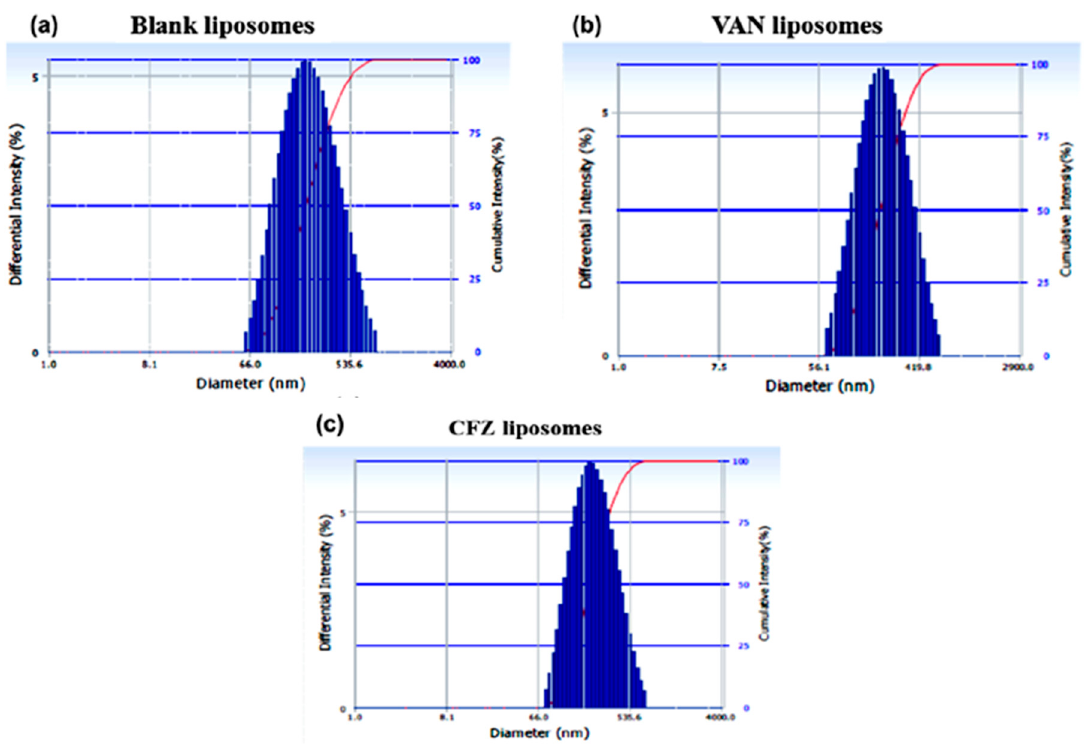
Figure 1. Histograms of vesicle sizes of liposomes ( a ) without drug (blank liposomes); ( b ) vancomycin (VAN) liposomes and ( c ) cefazolin (CFZ) liposomes showing a uniform size distribution.